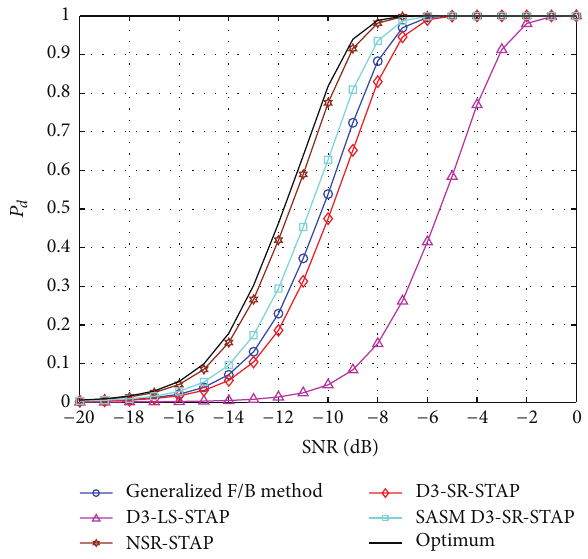
Figure 8: 𝑃 𝑑 versus the target SNR in the ideal